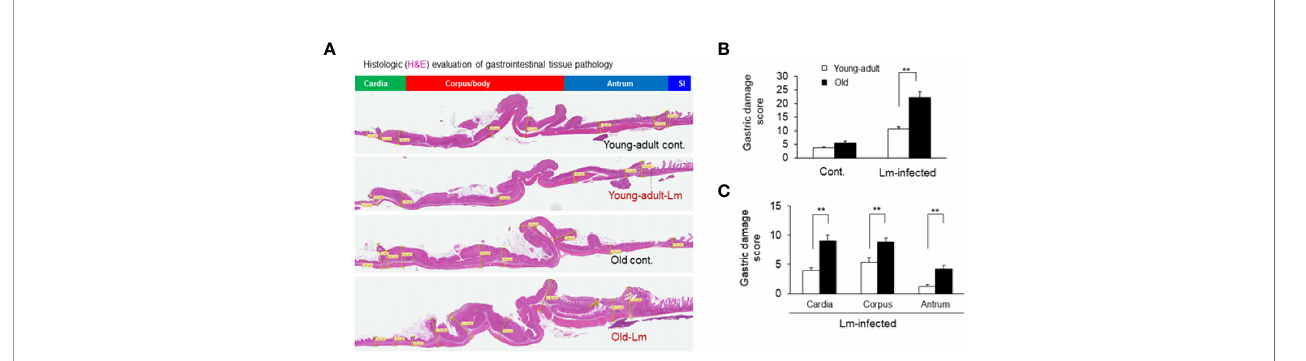
FIGURE 6 | Gastric in fl ammation was more severe in Listeria monocytogenes – infected old mice. Mice were infected by gavage with 1 x 10 6 CFU of L. monocytogenes per inoculation for two days, in consecutive, separate inoculations. Mice were euthanized 7-days post infection, and gastric tissue was processed for histologic examination. (A) Hematoxylin-eosin – stain of gastric sections from representative control (uninfected) or infected young-adult mice (top two), and control (uninfected) or infected old mice (bottom two). (B, C) Histologic scoring of gastritis in uninfected and infected young-adult and old mice. Data from mean ± SEM from a representative experiment using 4 – 6 mice. **p <